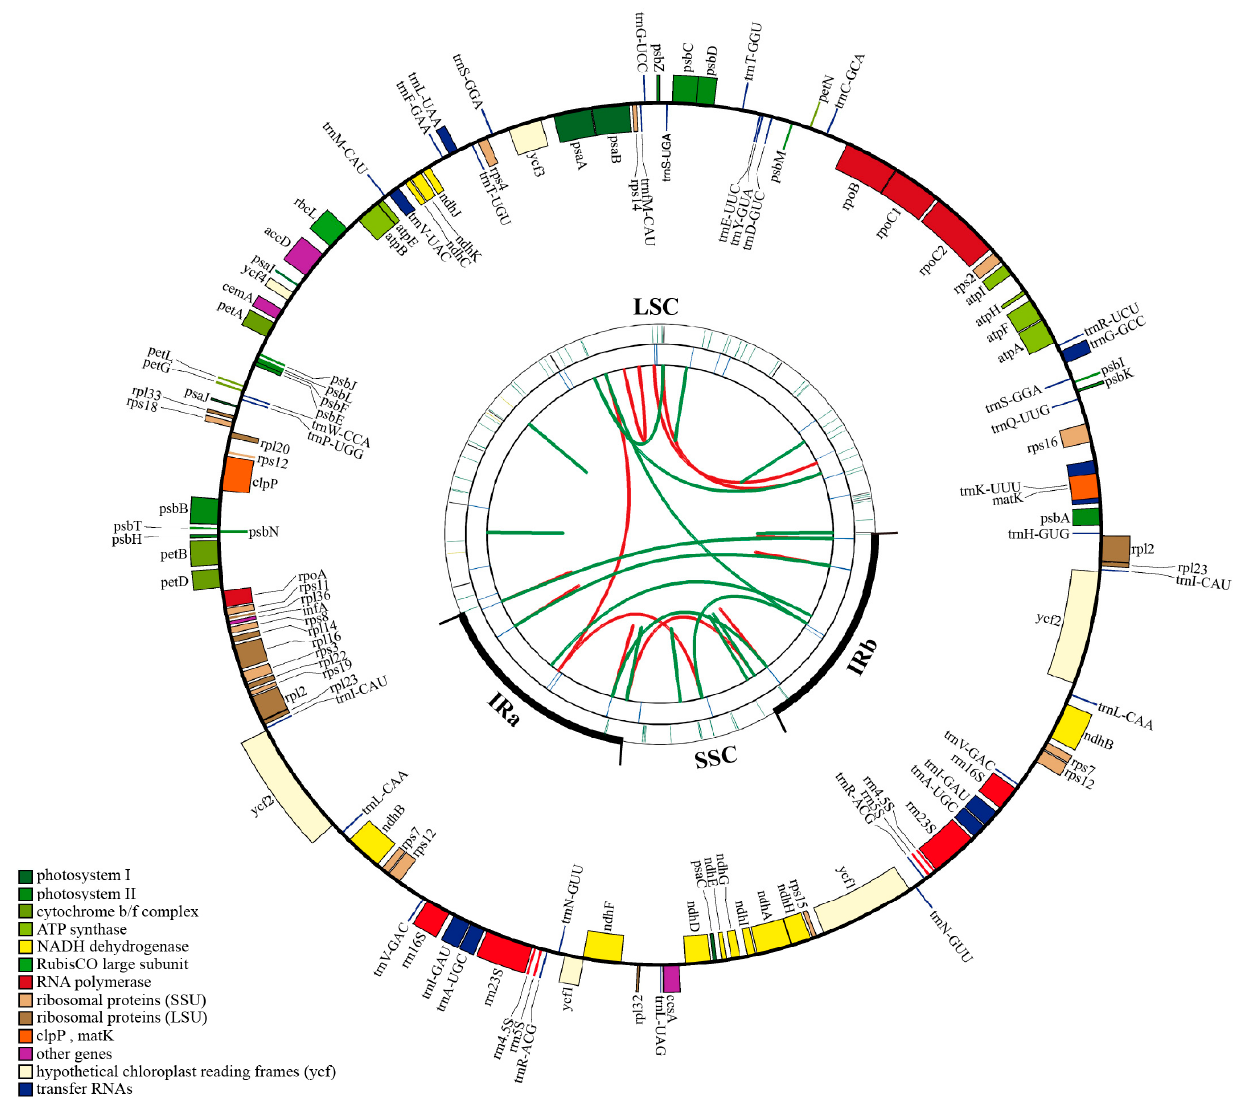
Figure 1. Gene map of the chloroplast genome of Q. litseoides . The chloroplast genome map has four circles. Outward from the center, the first circle shows forward and reverse repeats connected by red and green arcs, respectively. The second circle shows tandem repeats marked with a short bar. The third circle is the SSRs identified by MISA. The fourth circle is drawn with drawgenemap to display the gene structure on the chloroplast genome. The genes shown outside of the circle are transcribed clockwise, while those inside of the circle are transcribed counterclockwise. Genes with different functional groups are identified by different colors.